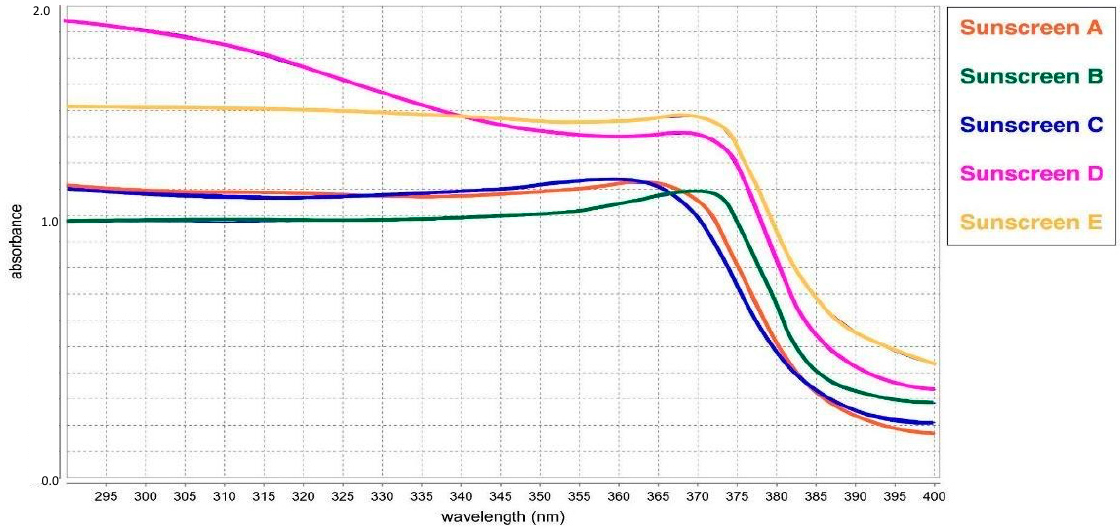
Figure 8. Absorption curves of the different formulations (A–E).